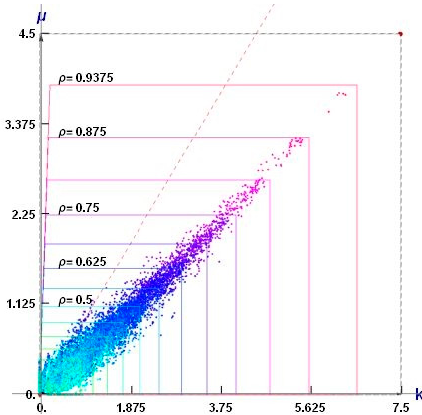
Figure 12. The sets of points of coordinates ( k H , μ H ) corresponding to the isotropic periodic composites of the two-phase cells (see Figure 9) for all possible black and white non-degenerated layouts for the given mesh. The axes are scaled differently, thus changing the Cherkaev–Gibiansky bounds into squares.